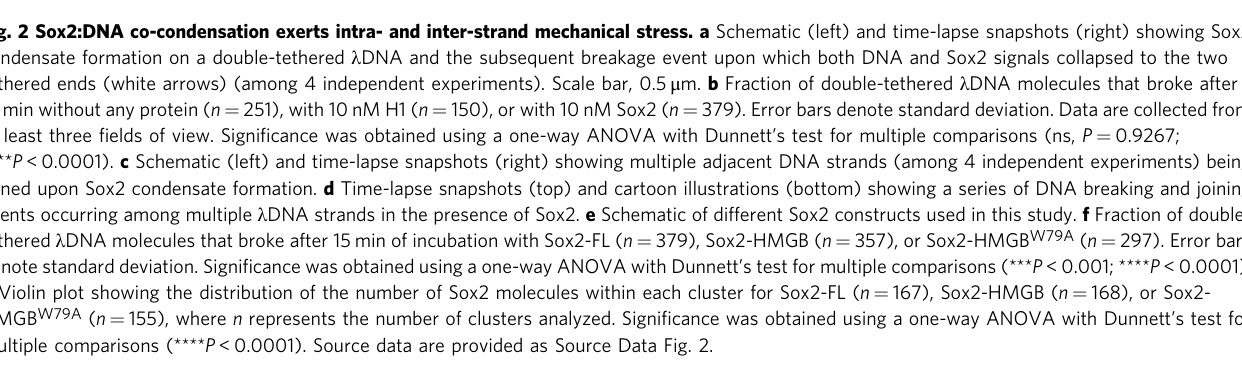
Fig. 2 Sox2:DNA co-condensation exerts intra- and inter-strand mechanical stress. a Schematic (left) and time-lapse snapshots (right) showing Sox2 condensate formation on a double-tethered λ DNA and the subsequent breakage event upon which both DNA and Sox2 signals collapsed to the two tethered ends (white arrows) (among 4 independent experiments). Scale bar, 0.5 μ m. b Fraction of double-tethered λ DNA molecules that broke after 15 min without any protein ( n = 251), with 10 nM H1 ( n = 150), or with 10 nM Sox2 ( n = 379). Error bars denote standard deviation. Data are collected from at least three fi elds of view. Signi fi cance was obtained using a one-way ANOVA with Dunnett ’ s test for multiple comparisons (ns, P = 0.9267; **** P < 0.0001). c Schematic (left) and time-lapse snapshots (right) showing multiple adjacent DNA strands (among 4 independent experiments) being joined upon Sox2 condensate formation. d Time-lapse snapshots (top) and cartoon illustrations (bottom) showing a series of DNA breaking and joining events occurring among multiple λ DNA strands in the presence of Sox2. e Schematic of different Sox2 constructs used in this study. f Fraction of double- tethered λ DNA molecules that broke after 15 min of incubation with Sox2-FL ( n = 379), Sox2-HMGB ( n = 357), or Sox2-HMGB W79A ( n = 297). Error bars denote standard deviation. Signi fi cance was obtained using a one-way ANOVA with Dunnett ’ s test for multiple comparisons (*** P < 0.001; **** P < 0.0001). g Violin plot showing the distribution of the number of Sox2 molecules within each cluster for Sox2-FL ( n = 167), Sox2-HMGB ( n = 168), or Sox2- HMGB W79A ( n = 155), where n represents the number of clusters analyzed. Signi fi cance was obtained using a one-way ANOVA with Dunnett ’ s test for multiple comparisons (**** P < 0.0001). Source data are provided as Source Data